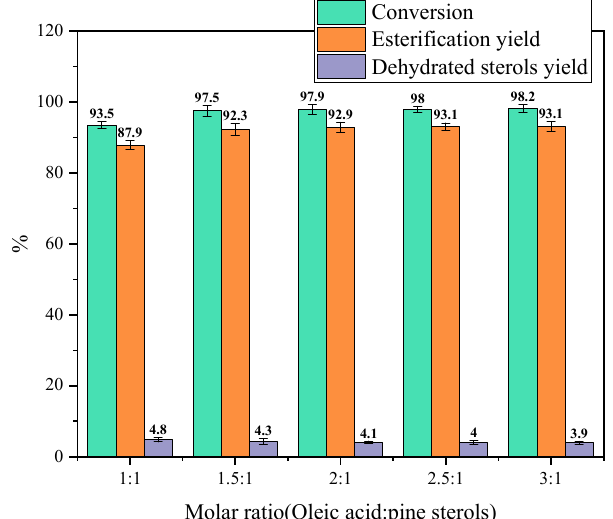
Figure 2. Effect of the molar ratio of oleic acid to pine sterols. Reaction conditions: 2 mmol pine sterols, 1% catalyst (based on the mass of pine sterols), 120 ◦ C, 5 h.